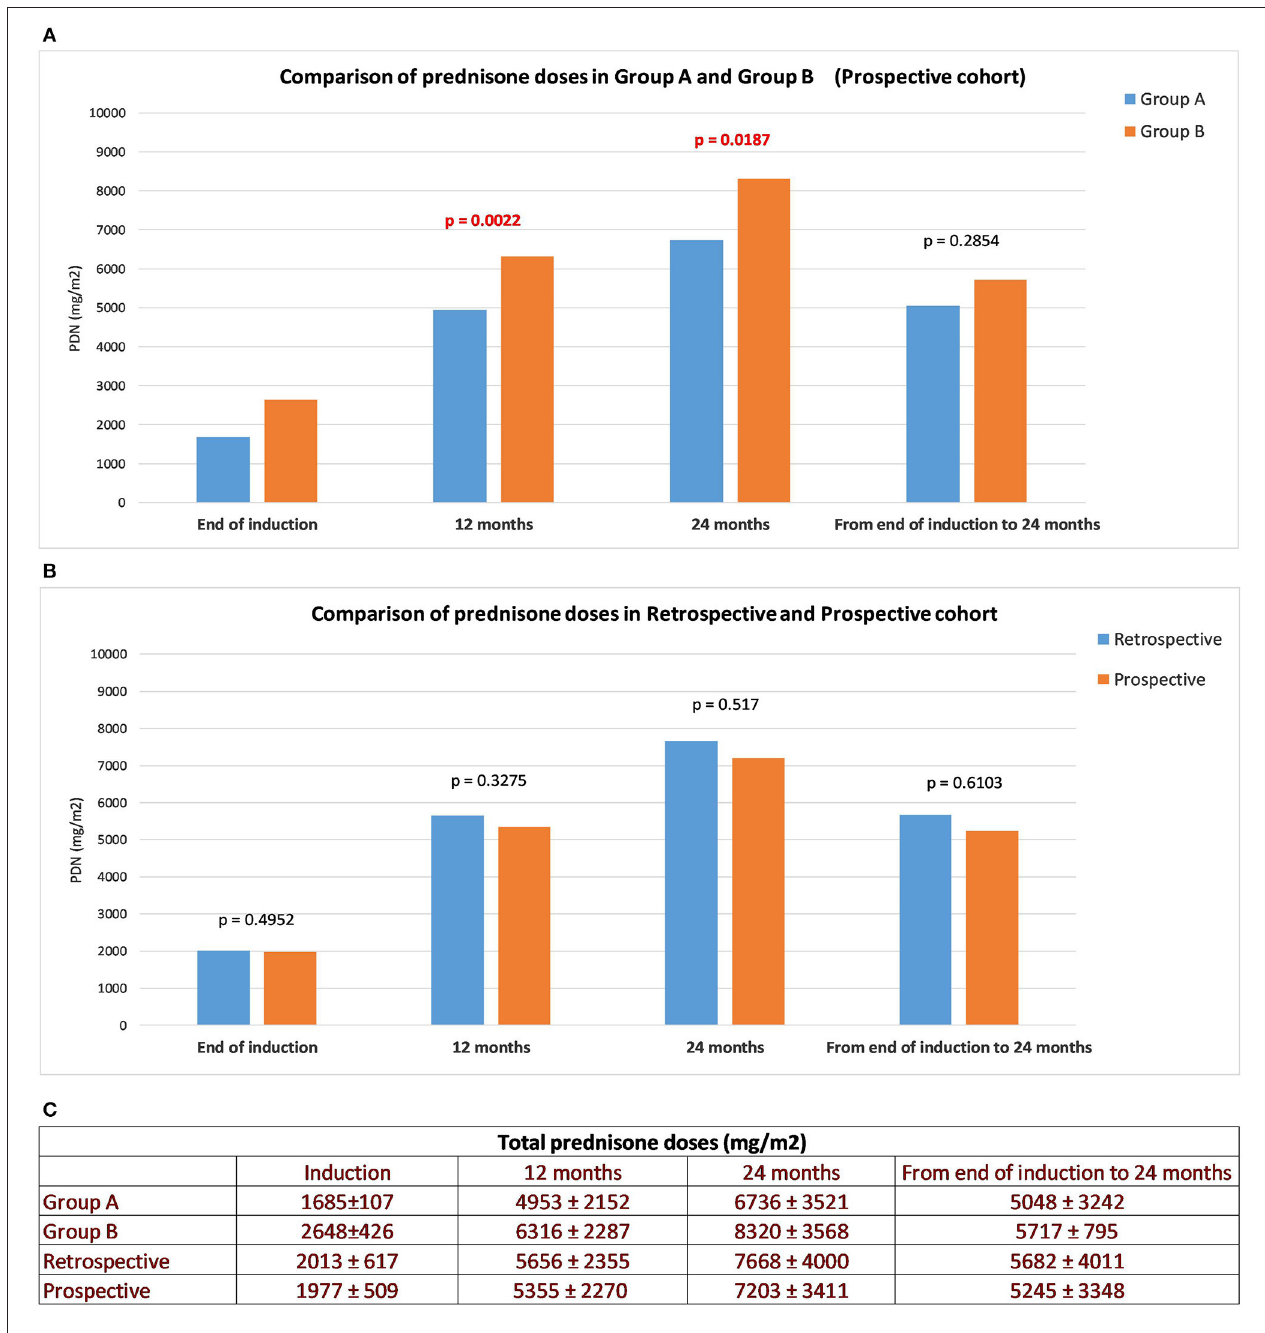
FIGURE 3 | Cumulative prednisone doses. Total daily PRED dose, cumulative PRED dose at 12, 24 months and from the end of induction to the end of follow-up: Group A vs. B (A) , prospective vs. retrospective cohort (B) . All values are means ± SD (mg/m 2 ) (C)